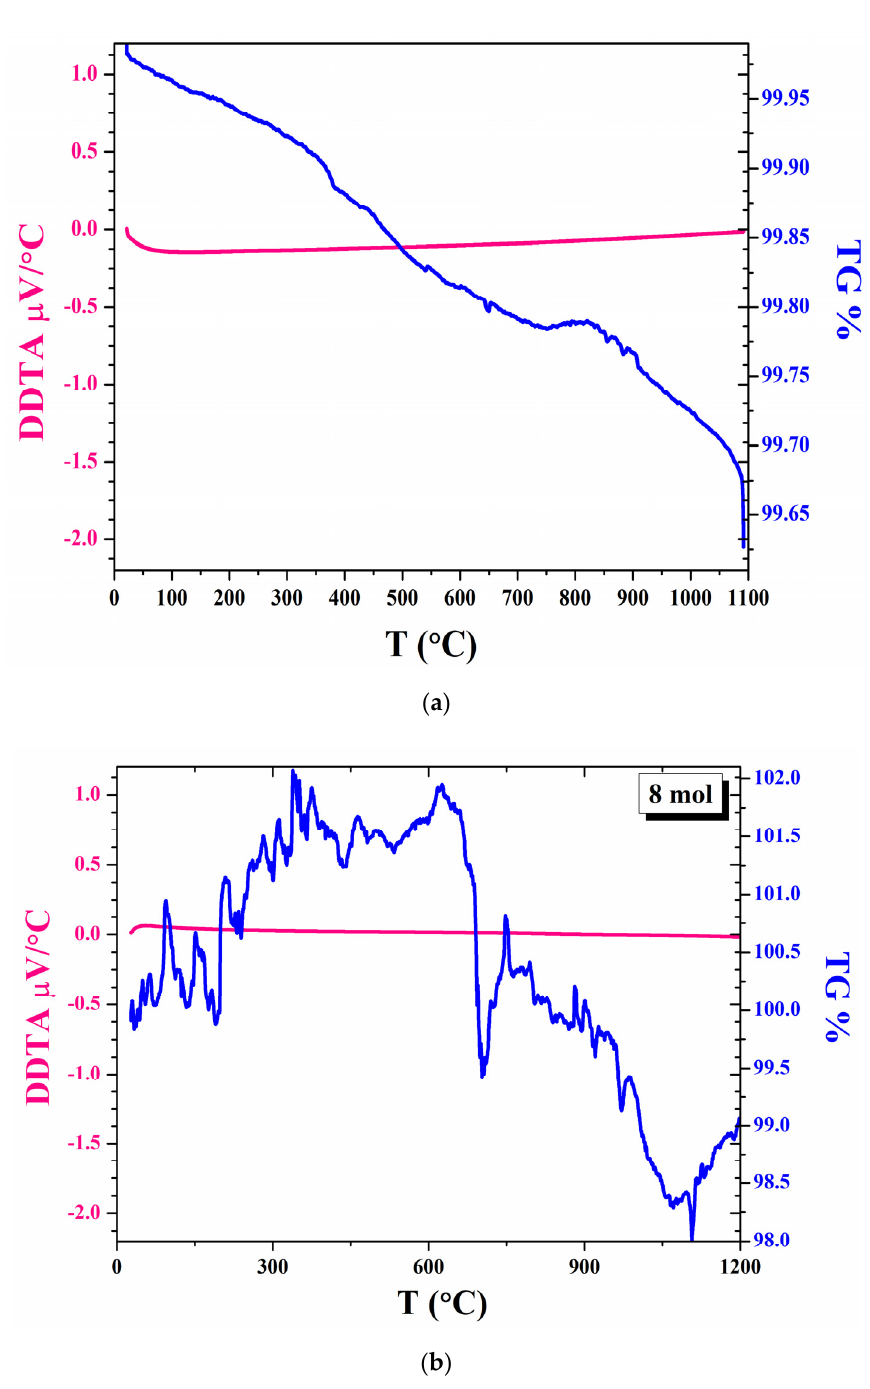
Figure 4. TGA/DTA diagram for GDZ-8 in the air; ( a ) powder calcined at 1200 °C for 12 h; ( b ) pellet sintered at 1500 °C.